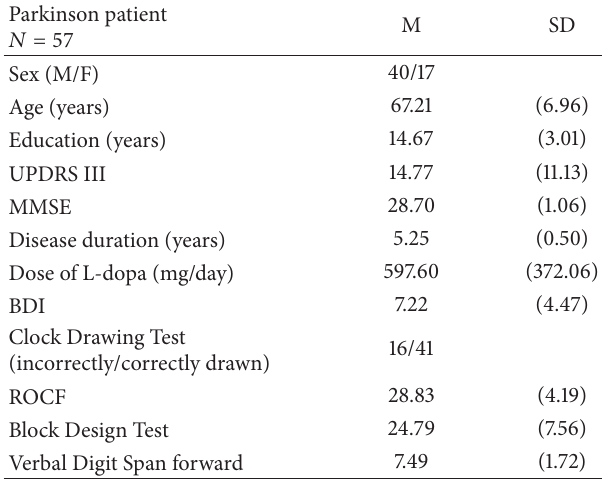
Table 1: Descriptive statistics and tasks performance of total